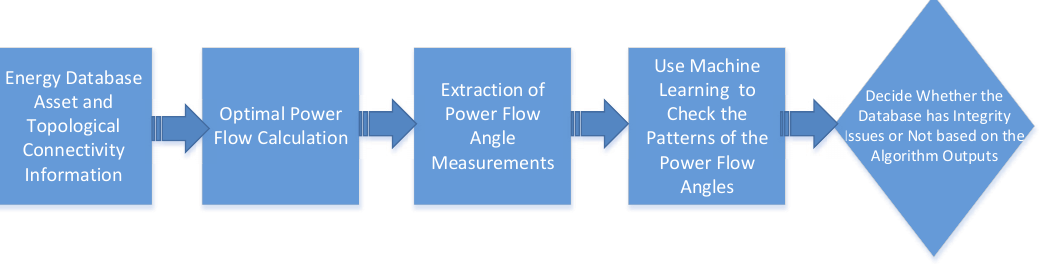
Figure 4. Proposed database anomaly detection